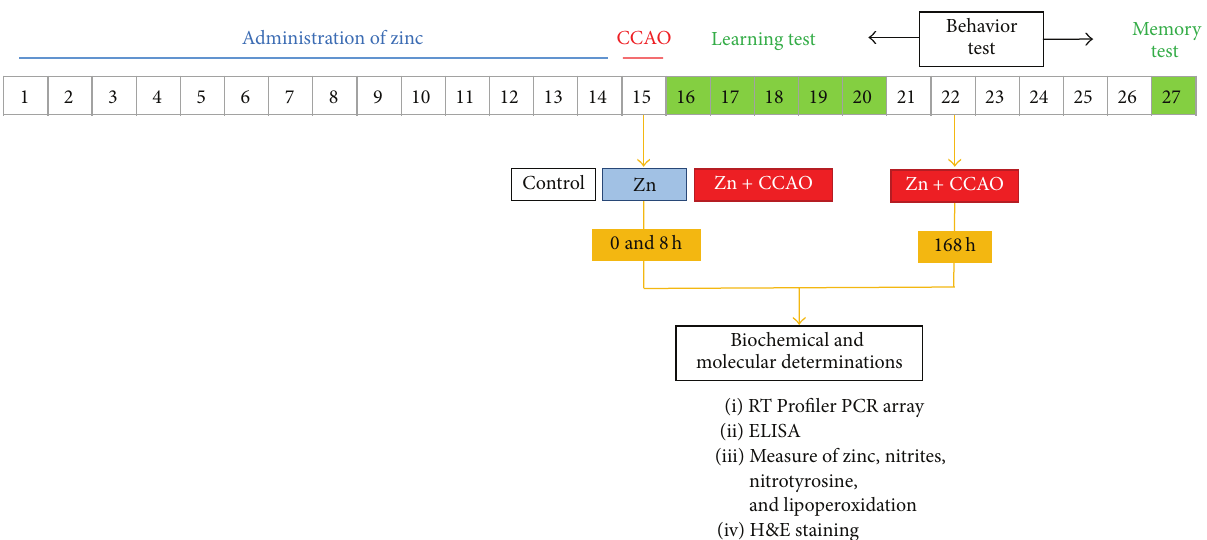
Figure 1: Experimental design of the chronic administration of zinc, performances of the learning test, and determinations of biochemical and molecular variables in Wistar